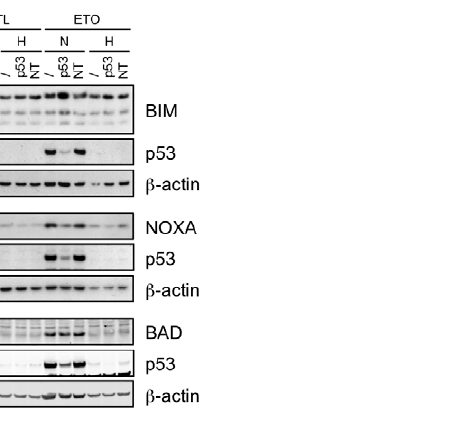
Figure 8. Effect of p53 silencing on the expression of BIM, NOXA and BAD. HepG2 cells were transfected with 50 nM p53 siRNA (p53) or non-targeting control siRNA (NT) or left untransfected (/) for 24 hours. Minimum 6 hours later, cells were incubated under normoxia (N, 21% O 2 ) or hypoxia (H, 1% O 2 ) with (ETO) or without (CTL) etoposide (50 m M) for 16 hours. Proteins were detected in total cell extracts by western blotting, using specific antibodies. ß-actin was used as loading control. One experiment representative out of three. Uncropped western blots are presented in Figure S1.